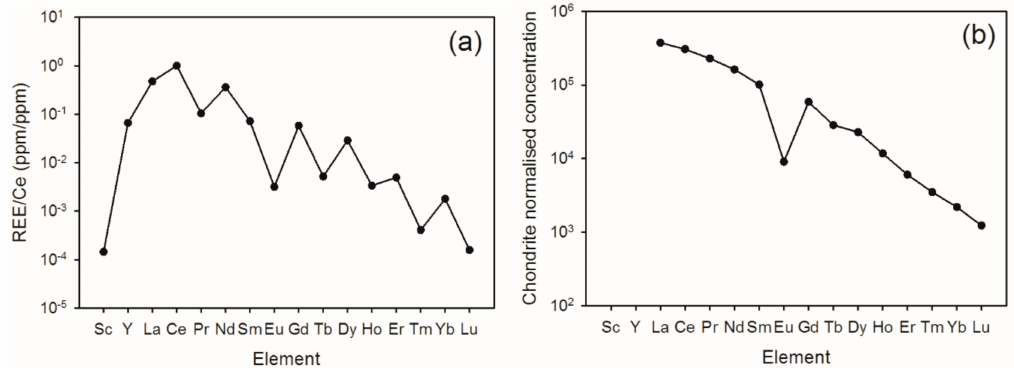
Figure 5. ( a ) Group 3 and rare earth element normalized composition of monazites (average of 18 grains); ( b ) chondrite normalized concentrations of the rare earth elements (from ( a )) showing the Eu anomaly.